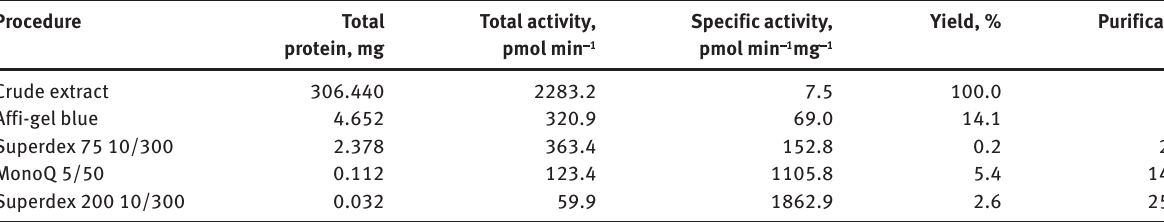
Table 1: Summary of the purification of AlrA protein from spr −